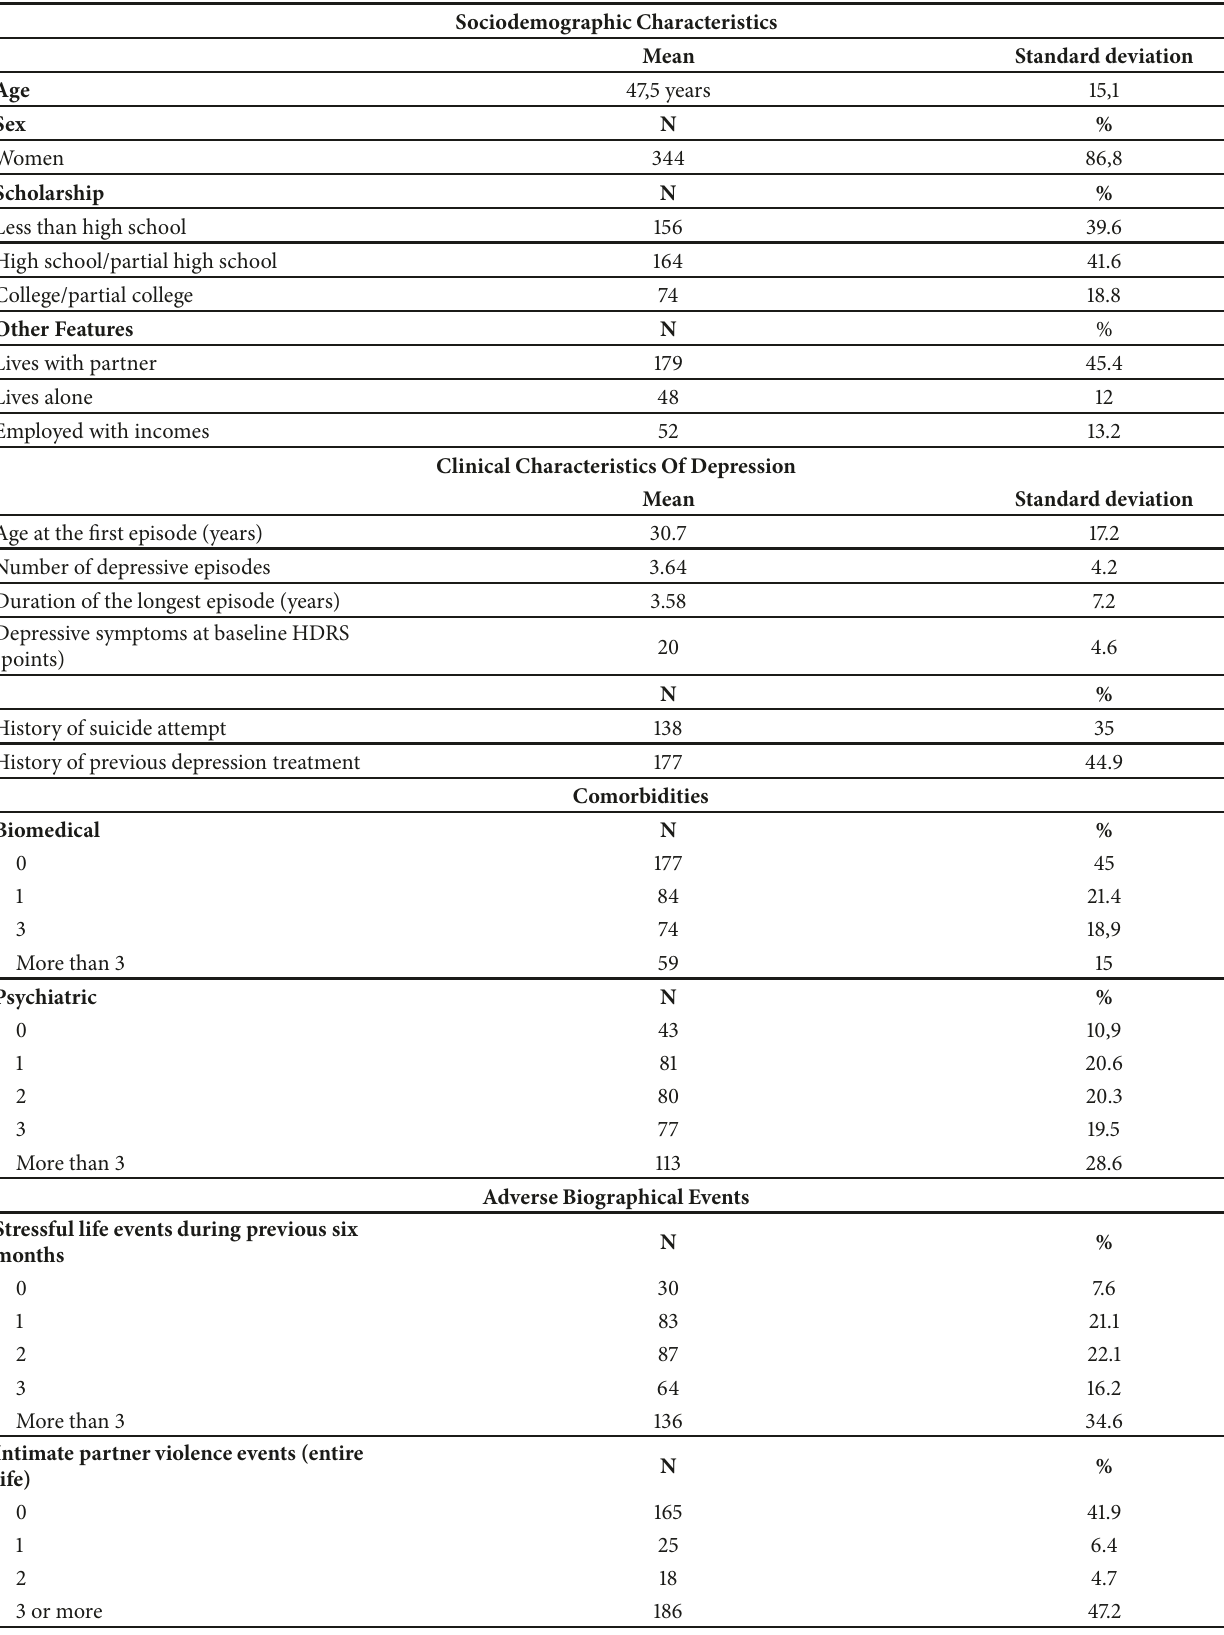
Table 1: Sociodemographic and clinical characteristics of sample in 394 primary care patients with depression, Maule region, Chile,